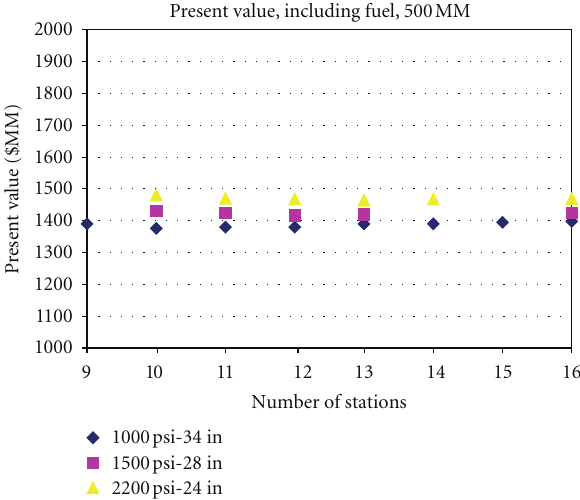
Figure 9: Optimum number of stations and optimum maxi- mum operating pressure (MAOP) for the 3220 km (2000 mile), 560000 Nm 3 /h sample pipeline. The lowest cost configurations for each MAOP solution are marked (from